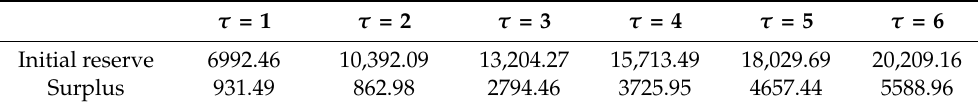
Table 7. Initial reserves for a quota q = 0.3 with a ruin probability Φ ( u , τ ) / Φ ( u ) = 0.01 and the resulting surplus at time τ .